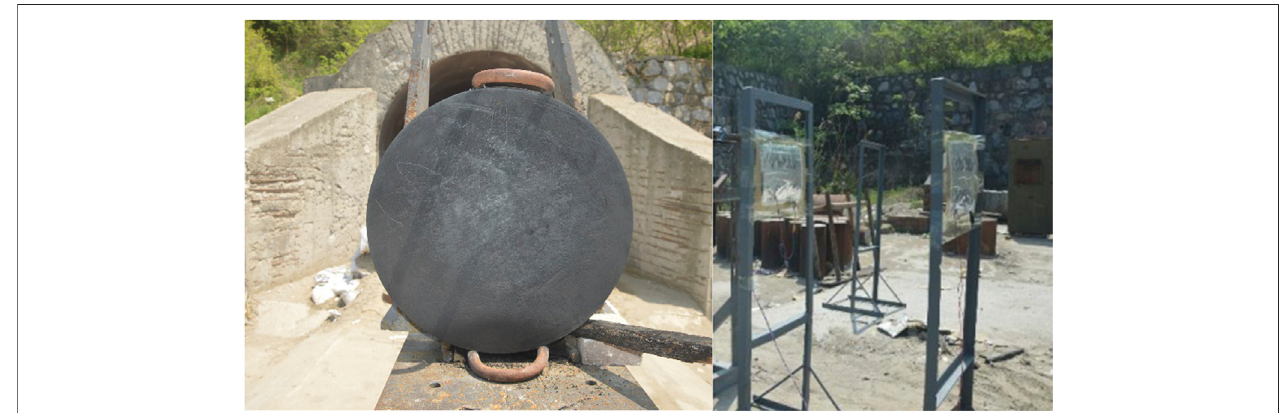
FIGURE 3 | G50 steel target and velocity measurement.